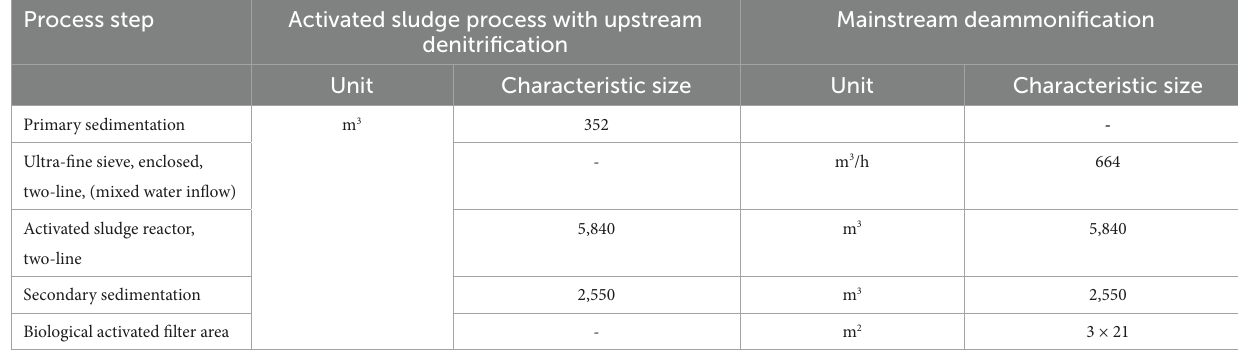
TABLE 6 Estimated volumes for the new construction of the compared